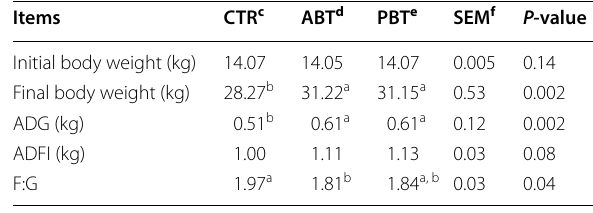
Table 2 Effects of dietary B. subtilis supplementation on growth performance of